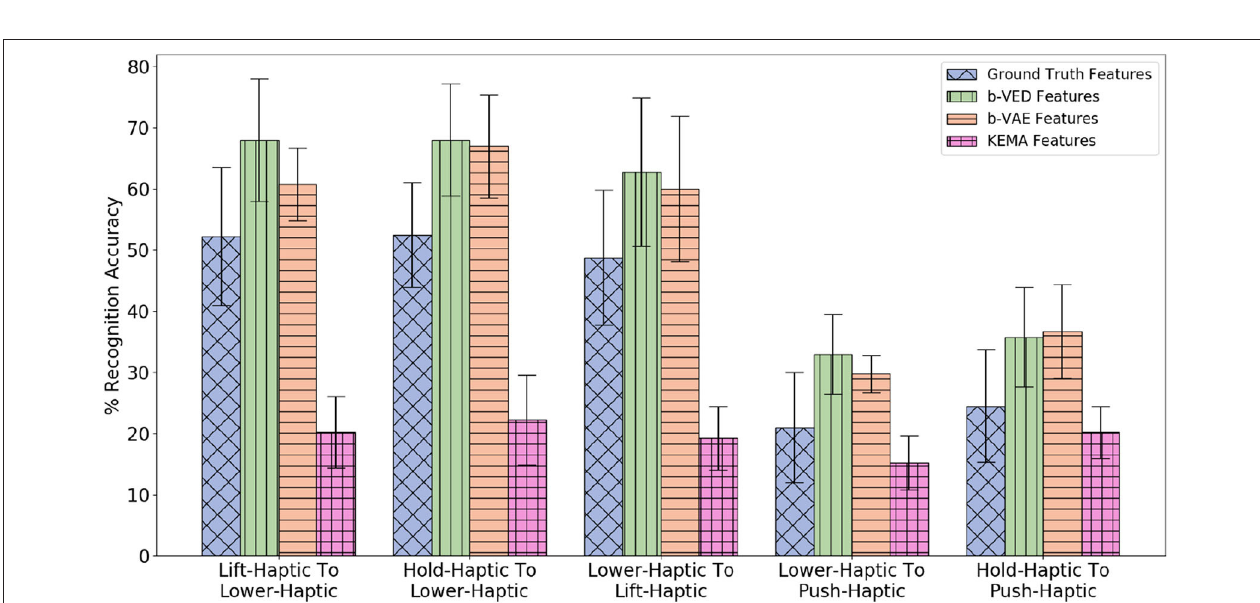
FIGURE 22 | β -VED cross-perception projections where the Accuracy Delta is minimum and corresponding β -VAE projections and KEMA projections for the dataset in Sinapov et al. (2016).